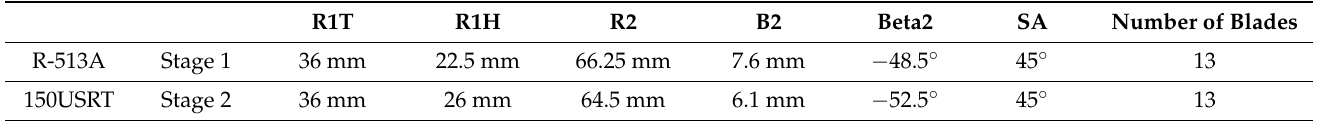
Table 4. Preliminary design of R513A, 150USRT two ‐ stage flow element.